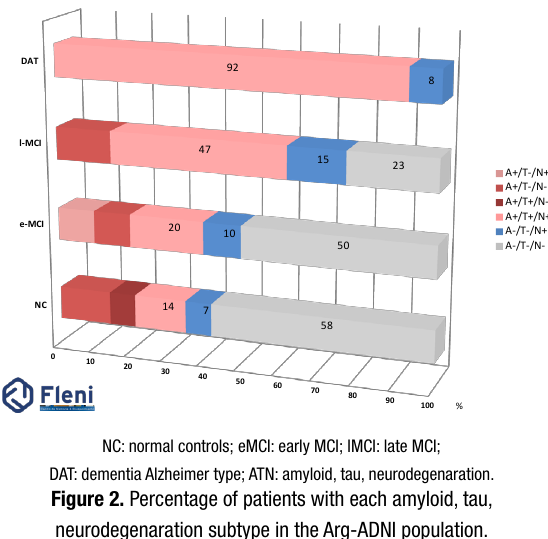
Figure 2. Percentage of patients with each amyloid, tau, neurodegenaration subtype in the Arg-ADNI population. In red positive amyloid and in blue